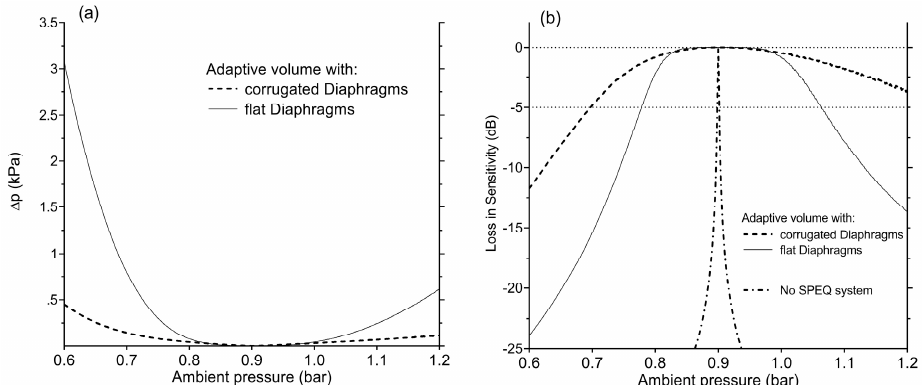
Figure 14. ( a ) Deviation from equilibrium between the internal and external pressure as a function of the ambient pressure between 600 and 1200 mbar. Considered is an adaptive volume (AV) containing two diaphragm pairs equipped with flat or corrugated diaphragms. The initial internal pressure is set to 900 mbar. ( b ) Loss in the intracochlear acoustic receiver’s (ICAR’s) sensitivity S m with ambient pressure variations relative to 900 mbar. For comparison, the drop in sensitivity of an ICAR without static pressure equalization (SPEQ) is shown